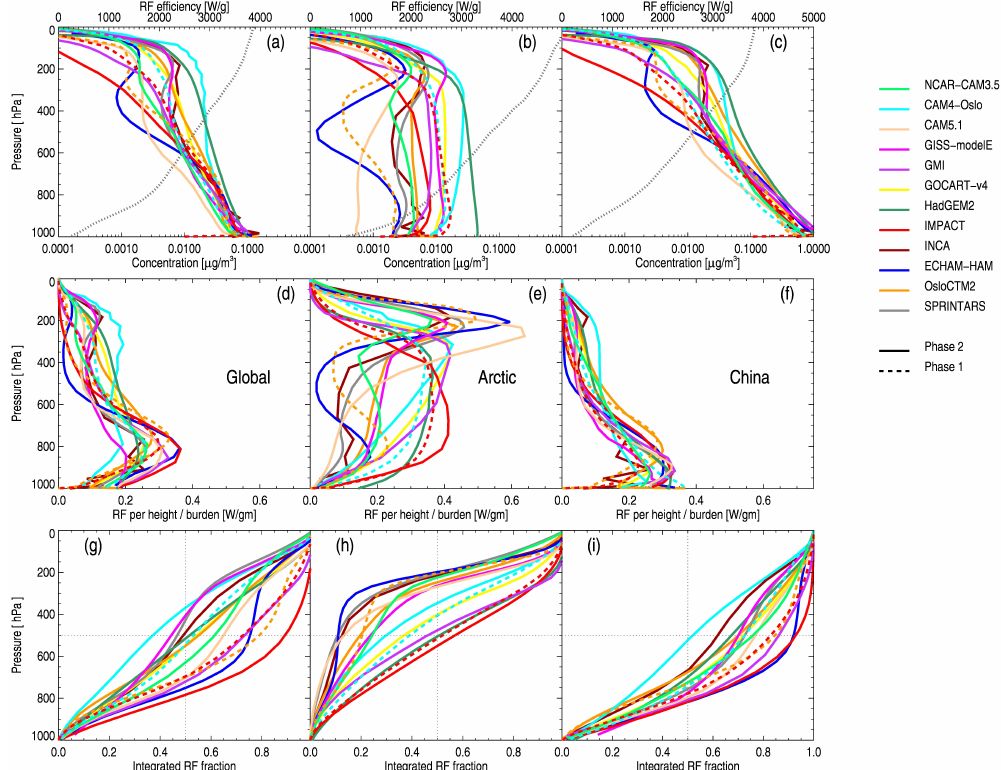
Fig. 2. Comparison of modeled concentration and RF profiles. (a–c) BC concentration vertical profiles, global mean and for two selected regions. Overlain is the annual mean forcing efficiency profile for the selected region (grey dashed line). Solid lines show AeroCom P2 submissions, dashed lines show P1. (d–f) BC RF per height, divided by the modeled global mean BC burden, globally and for three selected regions. (g–i) Vertical profile of integrated absolute BC RF. Lines indicate the 50% mark and 500hPa